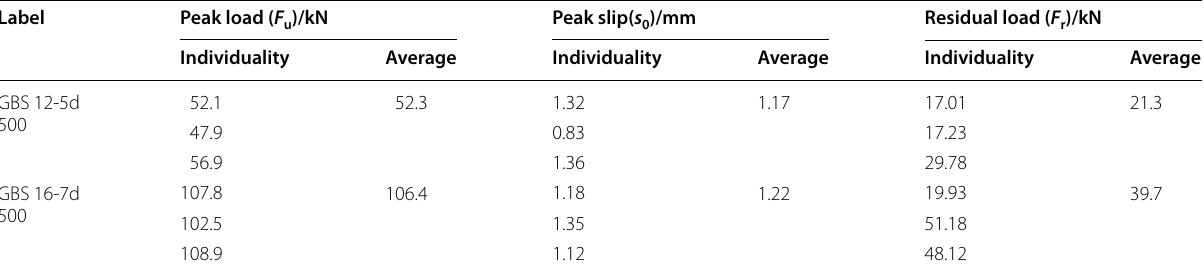
Table 2 Mechanical behavior parameters of specimens with the bond slip